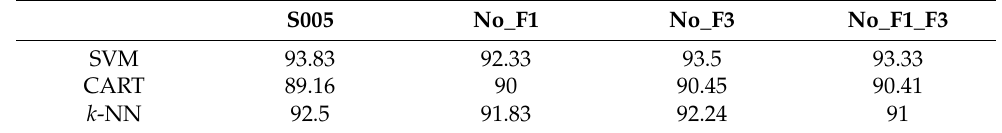
Table 9. The performances of the